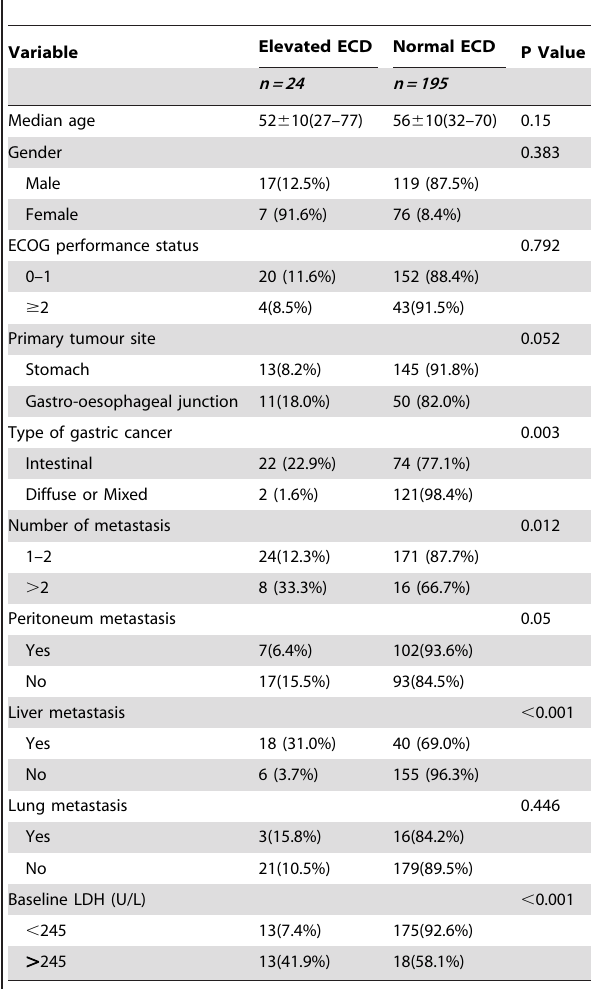
Table 2. Relationships between serum HER2 ECD levels and clinicopathological